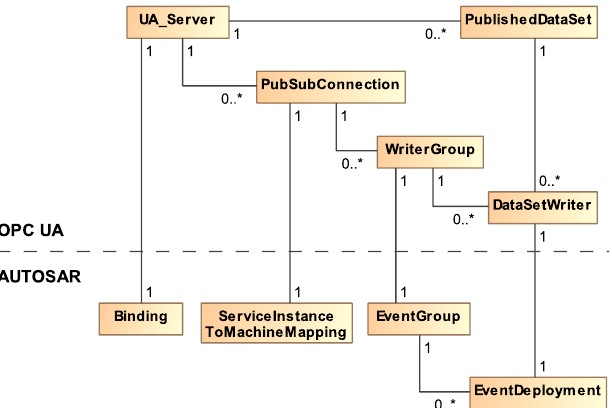
Figure 13. Mapping of AUTOSAR and OPC UA configuration entities for events (extension of [26] (Figure 17)). (0..*) denotes the association to none or at least one